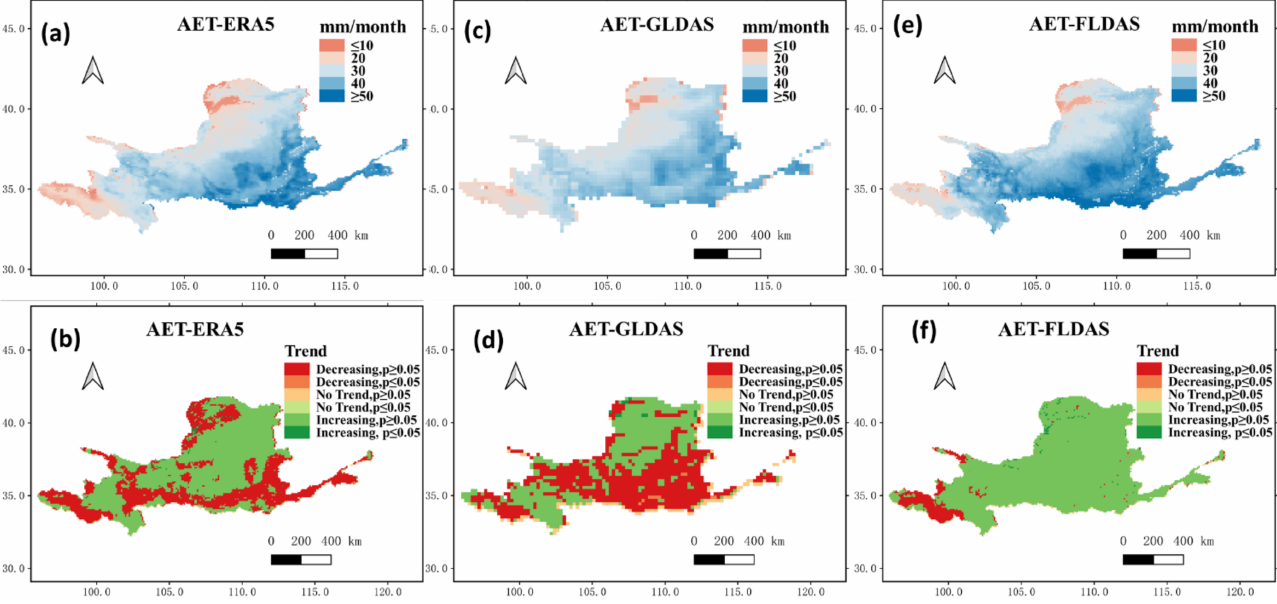
Figure 4. Spatial distribution ( a – e ) and trends ( b – f ) of monthly mean values of actual ET in the YRB with three different input data sources, ERA5: ( a , b ); GLDAS: ( c , d ); FLDAS: ( e , f